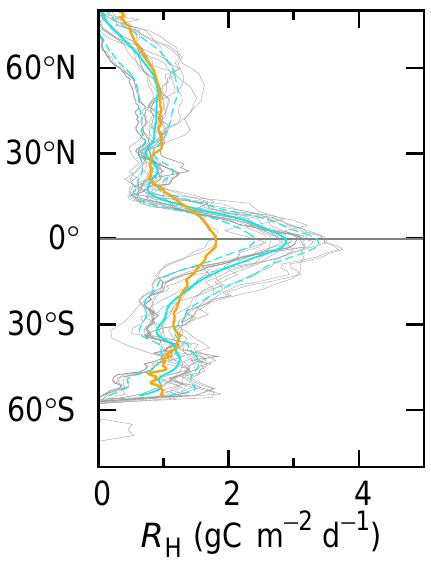
Figure 10. Latitudinal distribution of heterotrophic respiration. The orange line represents the results of this study. The grey lines are the results from the 20 Earth system models (please see Table S2). A smoothing spline was fit to each result because of the variation in the grid sizes of the Earth system models. The solid blue lines and broken blue lines indicate the mean and standard deviation, respec- tively, of the results of the 20 Earth system